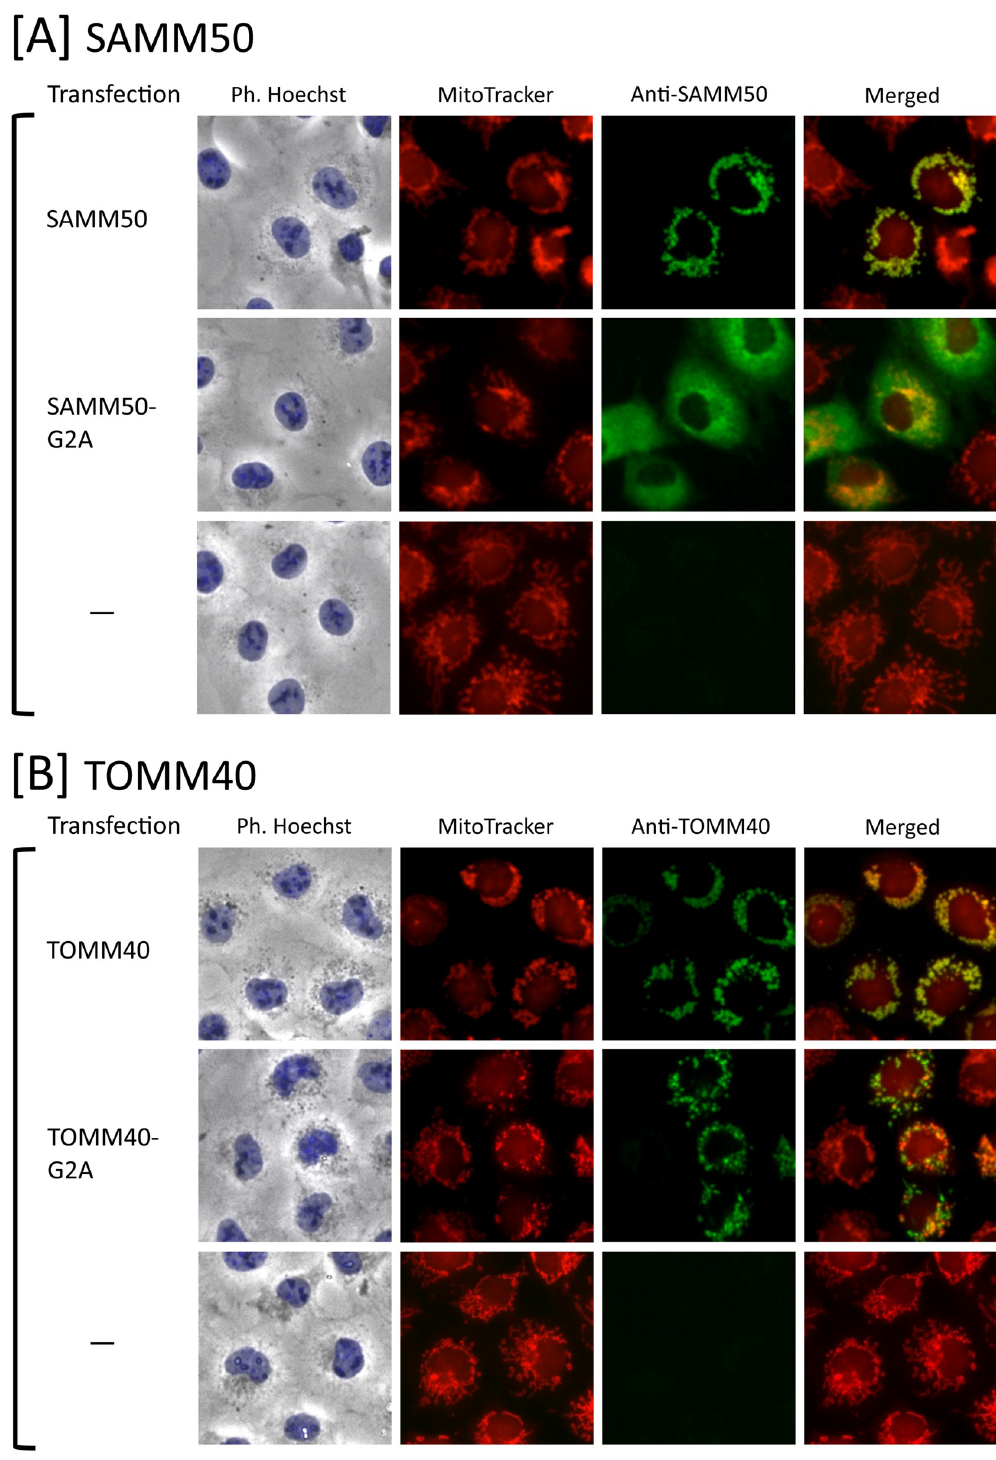
Fig 2. Protein N -myristoylation of SAMM50 but not of TOMM40 is required for proper targeting to mitochondria. A. Intracellular localization of SAMM50 and SAMM50-G2A was determined by immunofluorescence staining of COS-1 cells transfected with cDNAs encoding these two proteins using an anti-SAMM50 antibody. Mitochondria were detected using MitoTracker Red. The same experiment was performed using non-transfected COS-1 cells as a control. B. Intracellular localization of TOMM40 and TOMM40-G2A was determined by immunofluorescence staining of COS-1 cells